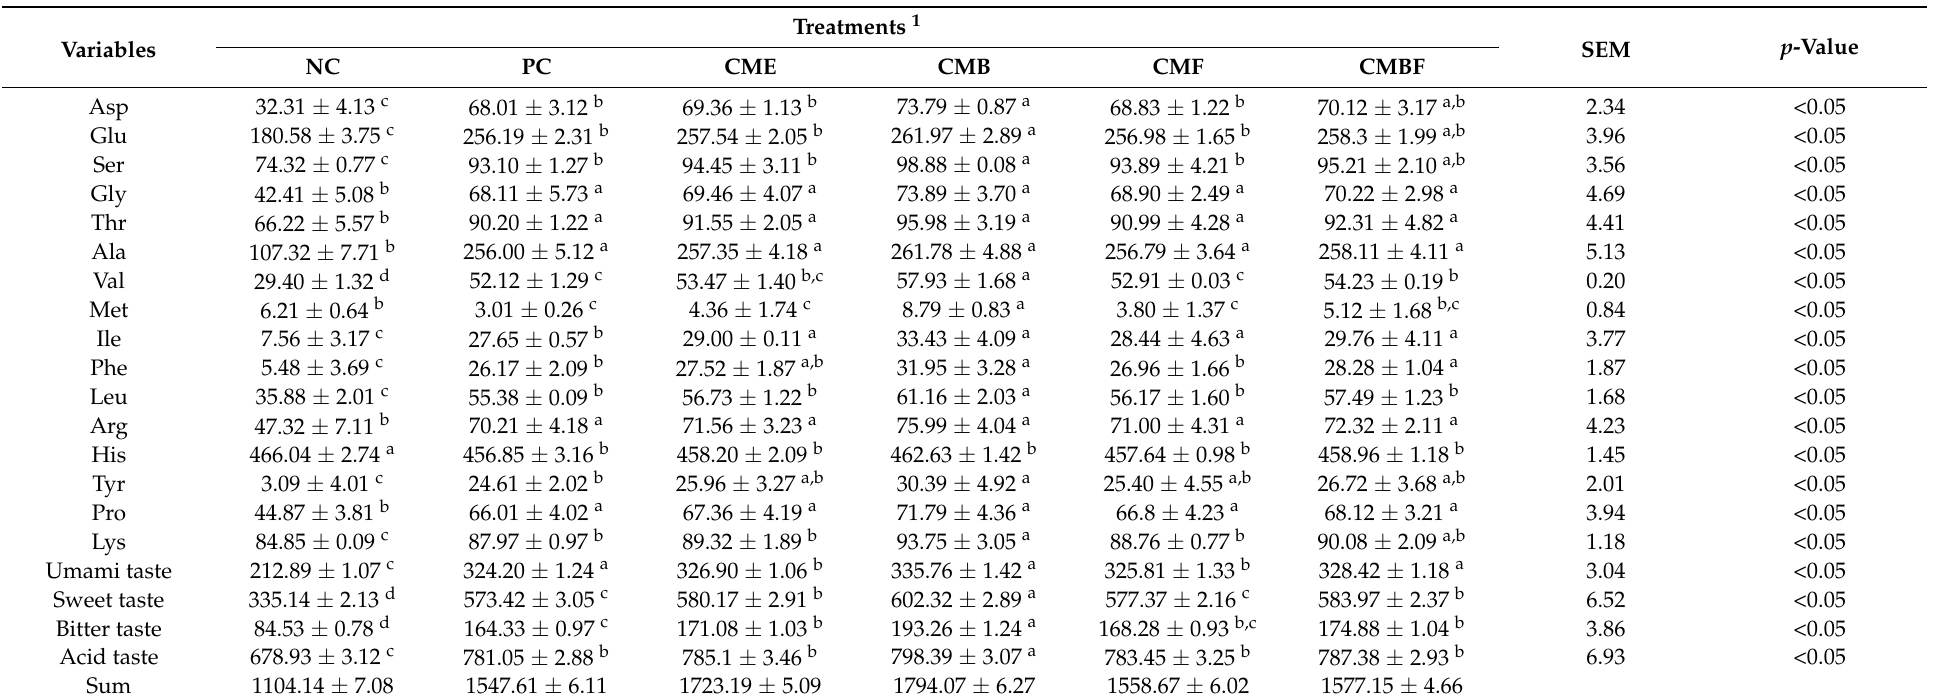
Table 7. Free amino acid profiles of the broth of Korean ginseng chicken soup that was hydrolyzed with Cordyceps militaris mushroom